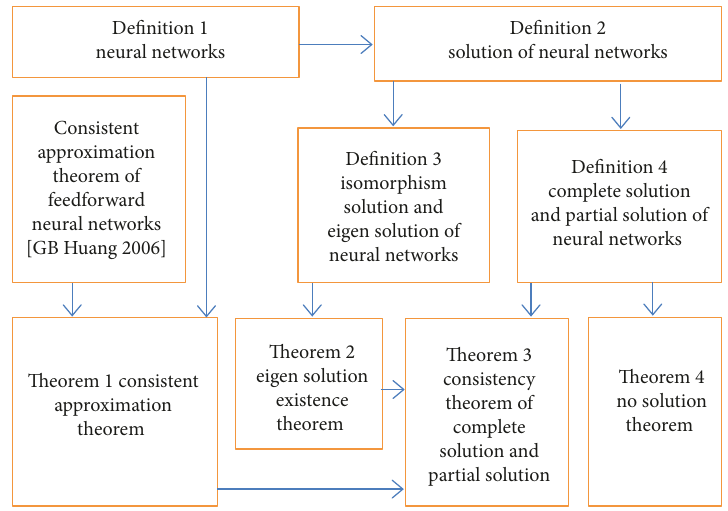
Figure 1: The relation of de fi nitions and